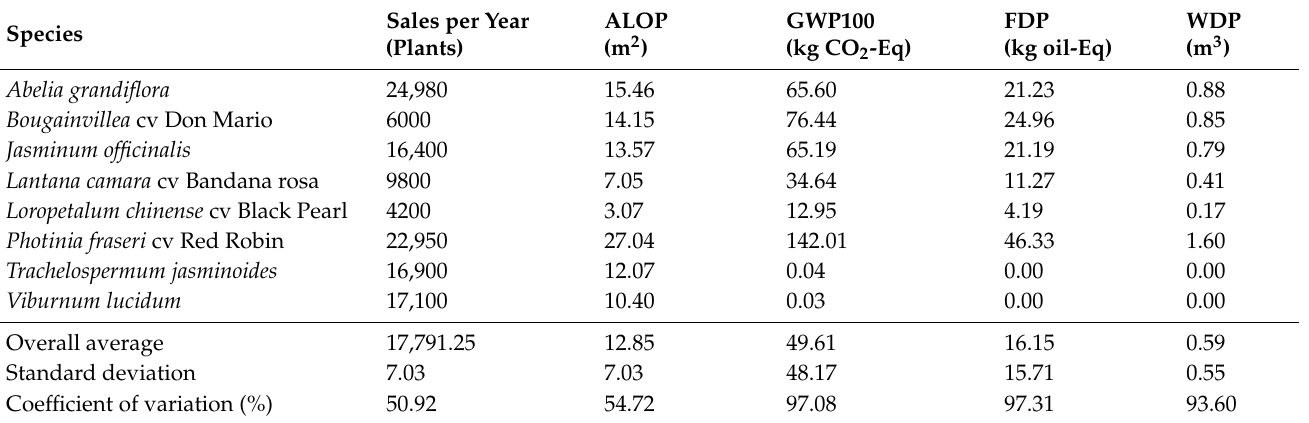
Table 10. Differences of environmental impacts associated with two production models: conventional production model (CM) and novel and sustainable production model (NSM), among 8 selected ornamental species at nursery level, study